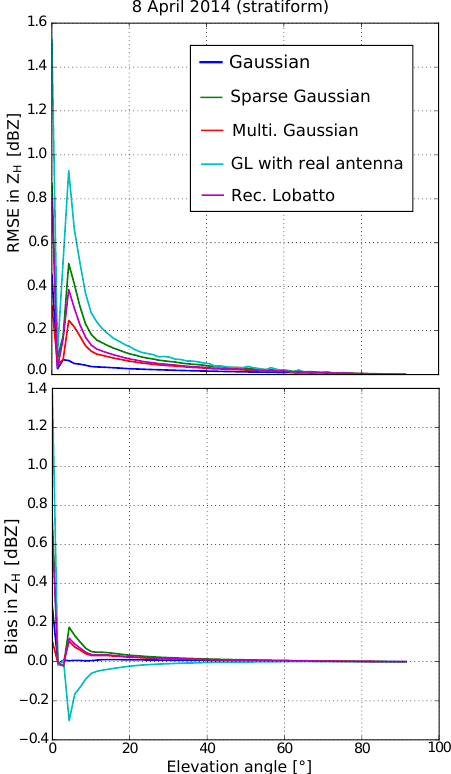
Figure 4. Bias and RMSE in terms of Z H during one day of strati- form of precipitation (around 120 RHI scans), for the five possible quadrature schemes. The exhaustive quadrature scheme is used as a reference. The other two events show similar results.